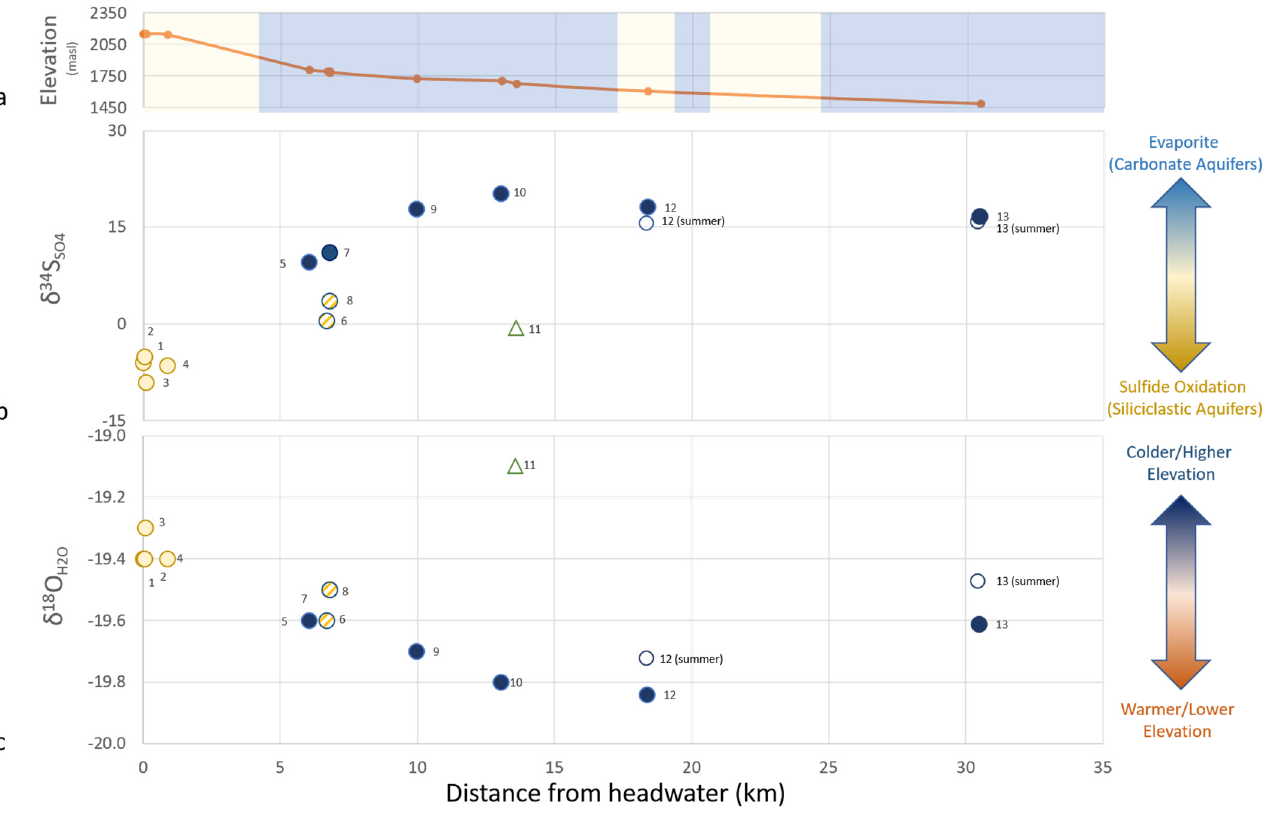
Figure 3. Longitudinal sampling results, including the ( a ) elevation profile of sampling points (orange) for Little Elbow and Elbow River, ( b ) δ 34 S SO4 and ( c ) δ 18 O H2O plotted as a function of sampling distance from the headwaters (filled circles and triangle). Yellow symbols have δ 34 S/ δ 18 O SO4 values that indicate derivation of sulfate from oxidation of sulfides and blue have intermediate or evaporite derived ratios (see Figure 4). Sample point numbers (Table 1) are indicated, and the triangle symbol is for a single tributary sample. Open circles and triangle are samples from 11 July 2017 to illustrate seasonal variation occurs but does not change overall trend.